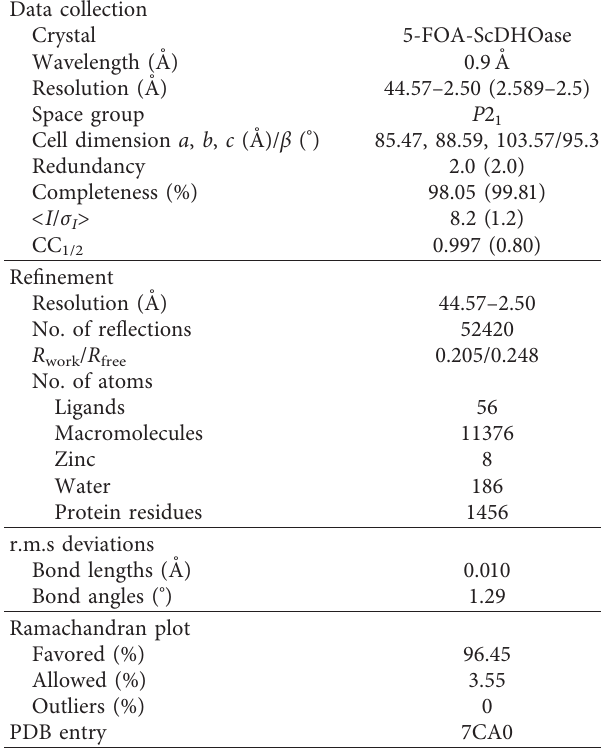
Table 1: Data collection and refinement